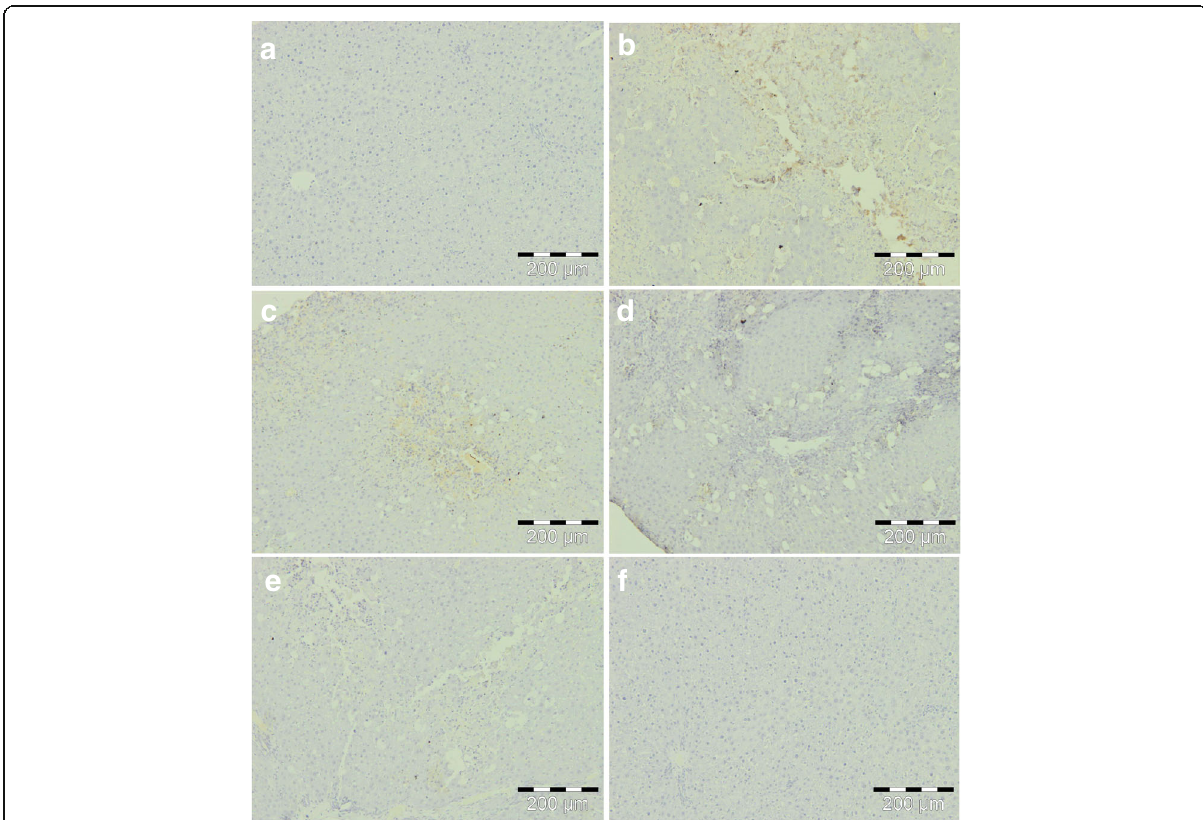
Fig. 11 Immunohistochemical appearance of IL-6. a Control group, normal. b CCl 4 (1 ml/kg b.wt.), high expression of IL-6. c C. nudiflora (150 mg/kg b.wt. +